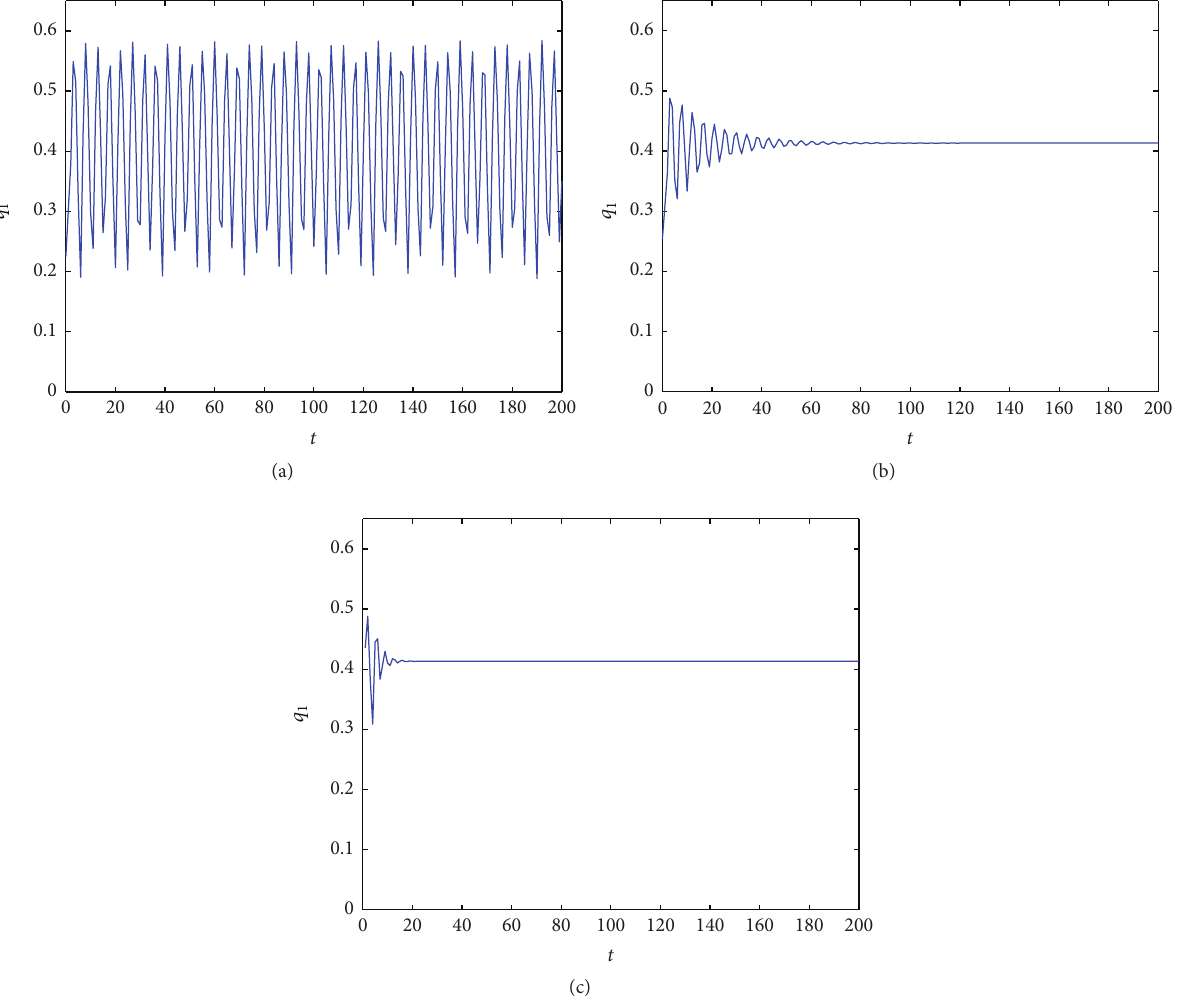
Figure 6: (a) Time series of output of firm 1 before using control function. (b) Time series of output of firm 1 after only firm 1 uses control function. (c) Time series of output of firm 1 after both firms use control